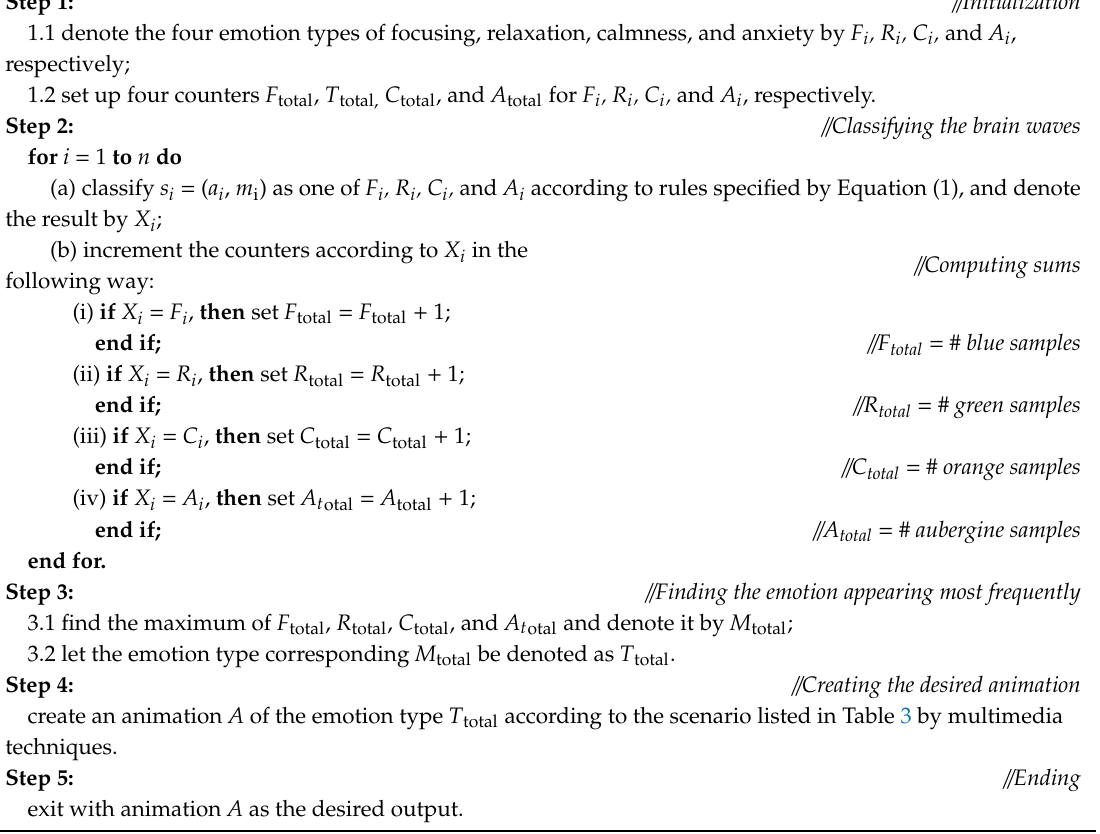
Algorithm 2 Generation of an emotion-representing